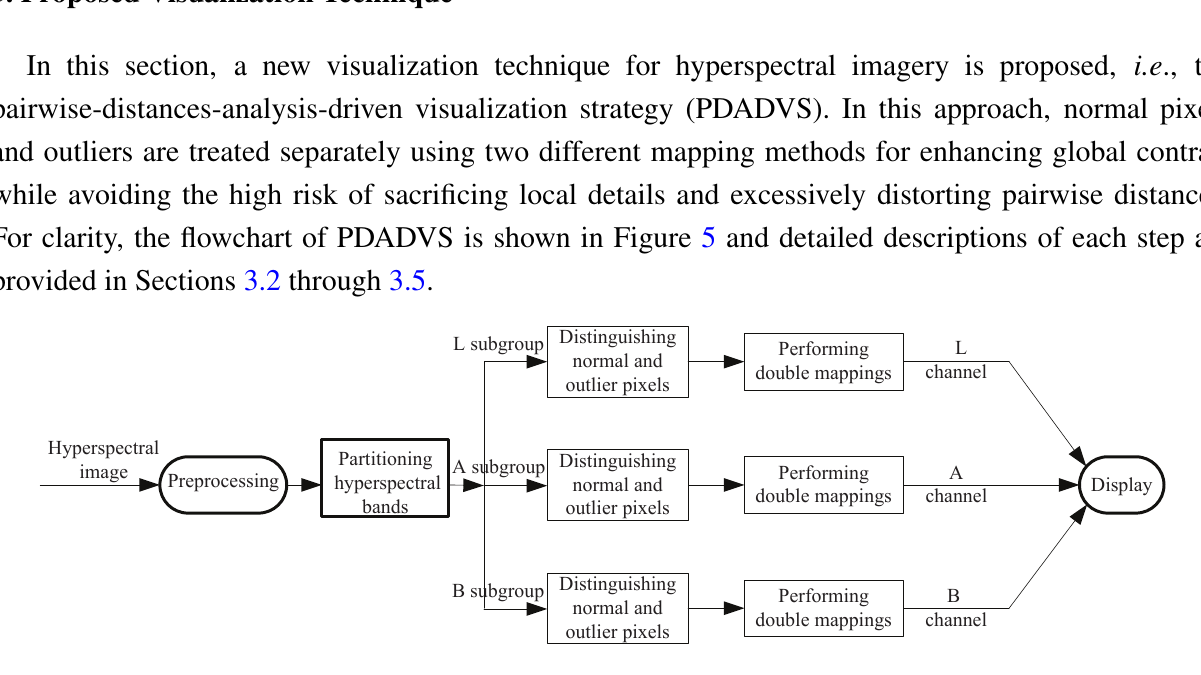
Figure 5. Flowchart of the proposed hyperspectral image visualization